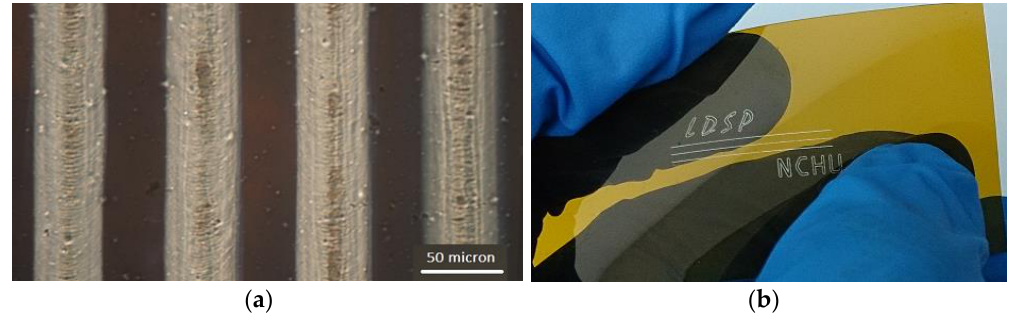
Figure 6. Silver lines fabricated on polyimide film substrate using LDSP (with ethylene glycol (EG) based solution): ( a ) microscopic picture of the silver line; ( b ) a demonstration of silver patterns on the flexible PI